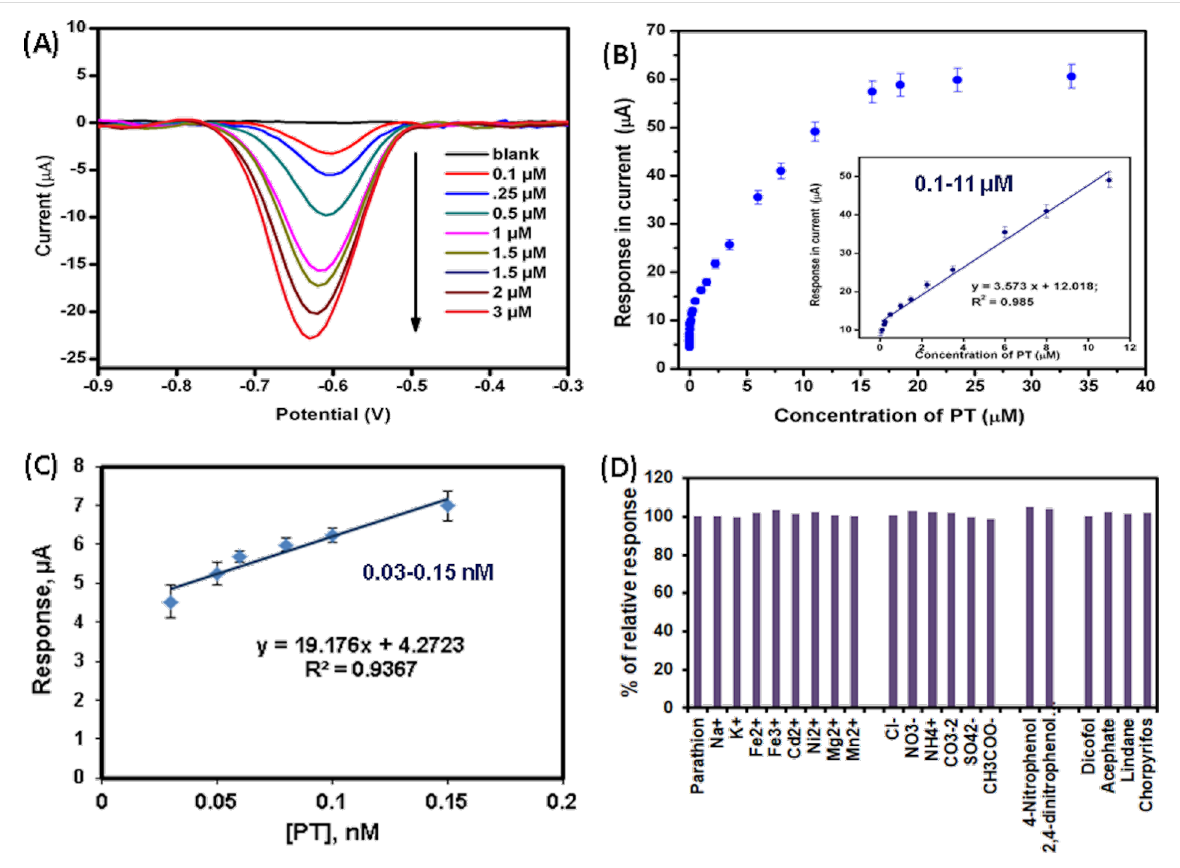
Figure 9: (A) SWV response of ERGO/GCE electrode in electrolytes (PBS, 0.05 M, pH 7) with different concentrations of PT ranging from 0.1 to 3 μ M. (B) Calibration plot of peak current as a function of PT concentration for a wide range (i.e., 3 × 10 − 5 to 11 µM, inset: linear regression curve for 0.1 to 11 µM) and (C) 0.03–0.15 nM. (D) Selectivity studies of PT (10 μ M) detection with probable interfering substances such as Na + , K + , Fe 2+ , Fe 3+ , Cd 2+ , Ni 2+ , Mg 2+ , Mn 2+ , NH 4 + , Cl − , NO 3 − , CO 3 2 − , SO 4 − , CH 3 COO − , 4-nitrophenol, 2,4-dinitrophenol, acephate, chlorpyrifos, dicofol, and lindane, re- spectively using SWV and keeping all other parameters constant. Experimental conditions: pulse amplitude: 100 mV, SWV frequency: 25 Hz, starting potential: 0.3 V, accumulation potential: − 0.1 V, and accumulation time: 240 s.